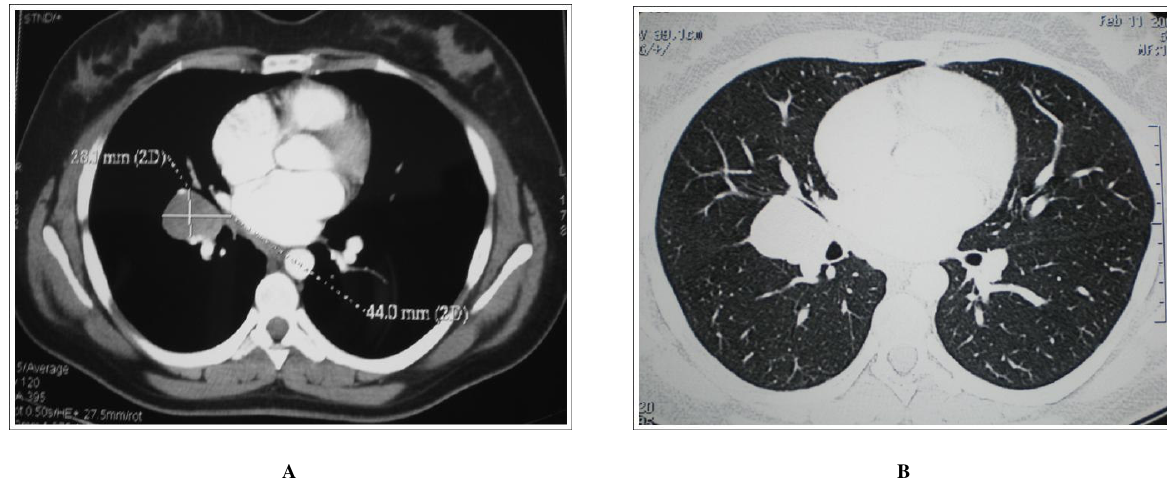
FIGURE 2. CT scan of the chest. (A) Presence of a homogenous tissue-density mass, 4.4 × 2.8 cm, located in the right interbronchial space and presenting poor CE. (B) The mass is compressing contiguous bronchial